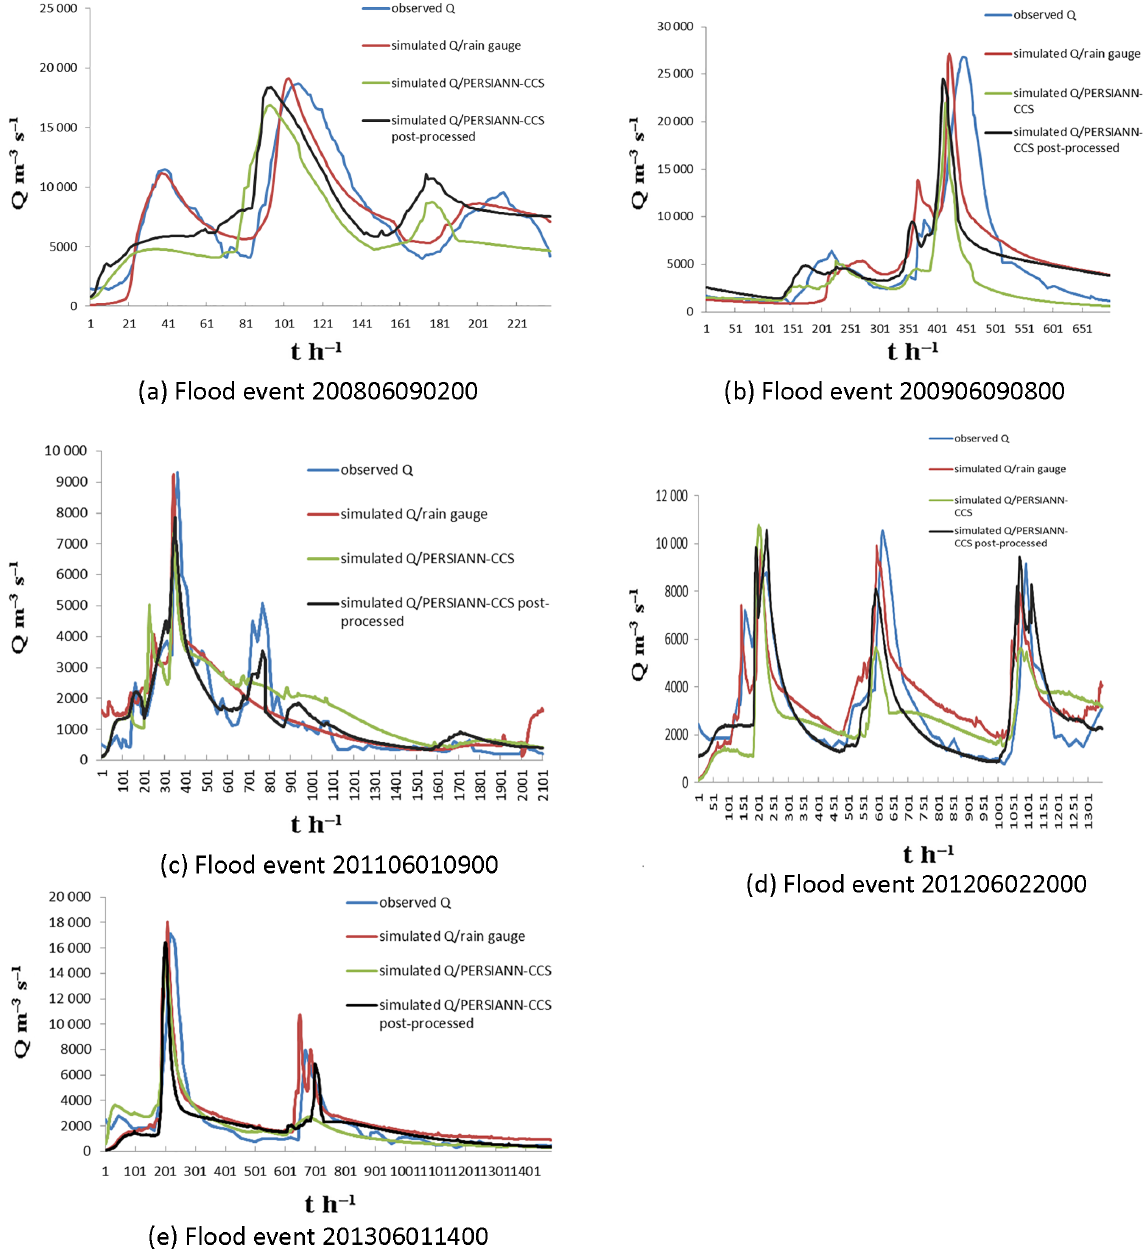
Figure 14. The flood simulation results of the coupled model with the two precipitation